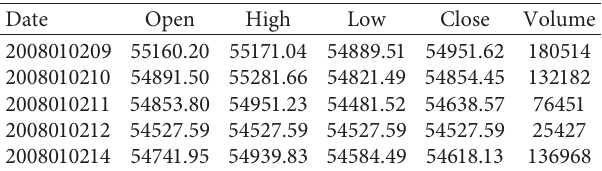
Figure 3: Conversion of ten seconds time period BIST 100 data to hourly OHLC. Table 1: BIST 100 hourly data